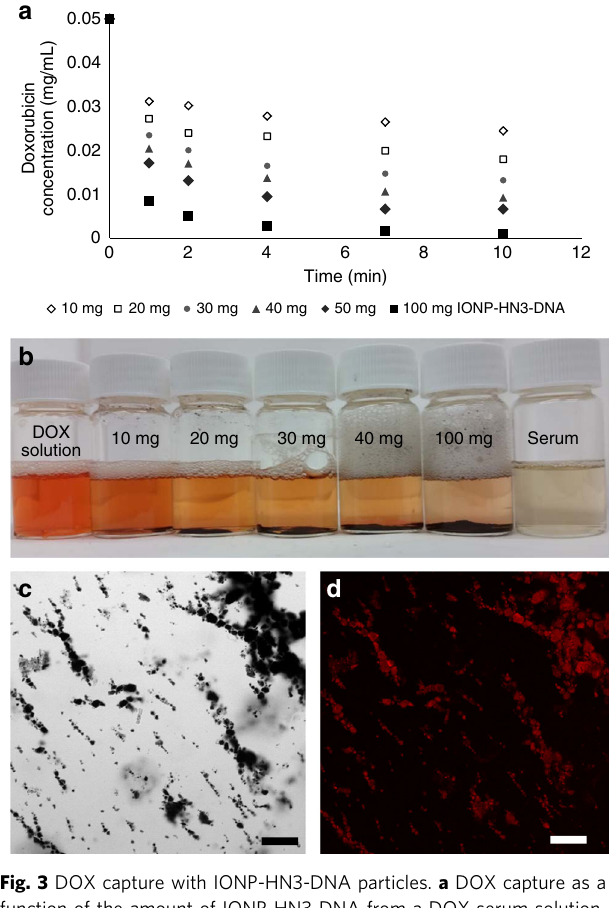
Fig. 3 DOX capture with IONP-HN3-DNA particles. a DOX capture as a function of the amount of IONP-HN3-DNA from a DOX serum solution (0.5 mg total DOX, 0.05 mg/mL); average of three experiments, data set with error bars in Supplementary Fig. 6. b Resulting serum solutions from experiments summarized in a . c Bright fi eld image of IONP-HN3-DNA aggregates bound to DOX; scale bar = 50 μ m. d Fluorescence from DOX bound to IONP-HN3-DNA; scale bar = 50 μ